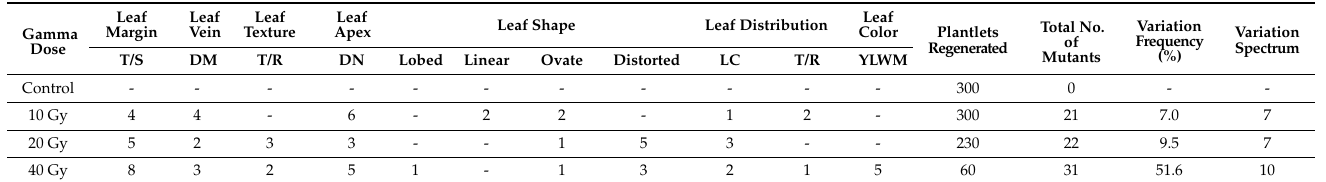
Table 2. Variation frequency and variation spectrum of leaf mutants derived from gamma-irradiated protocorms-like bodies (PLBs) of Dendrobium ‘Emma